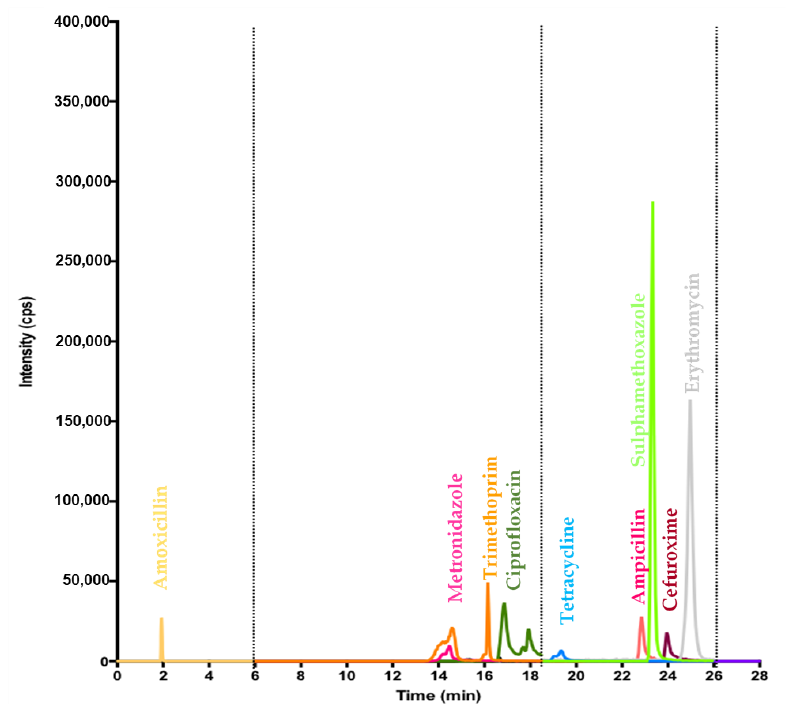
Figure 5. Chromatogram showing separated antibiotics and their peaks. The dotted vertical lines indicate 3 periods created during the analysis to improve upon the sensitivity and reliability of peak areas.